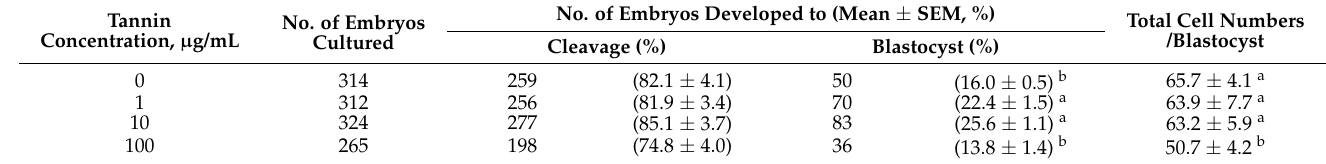
Table 4. Effects of tannin on embryo development competence after in vitro